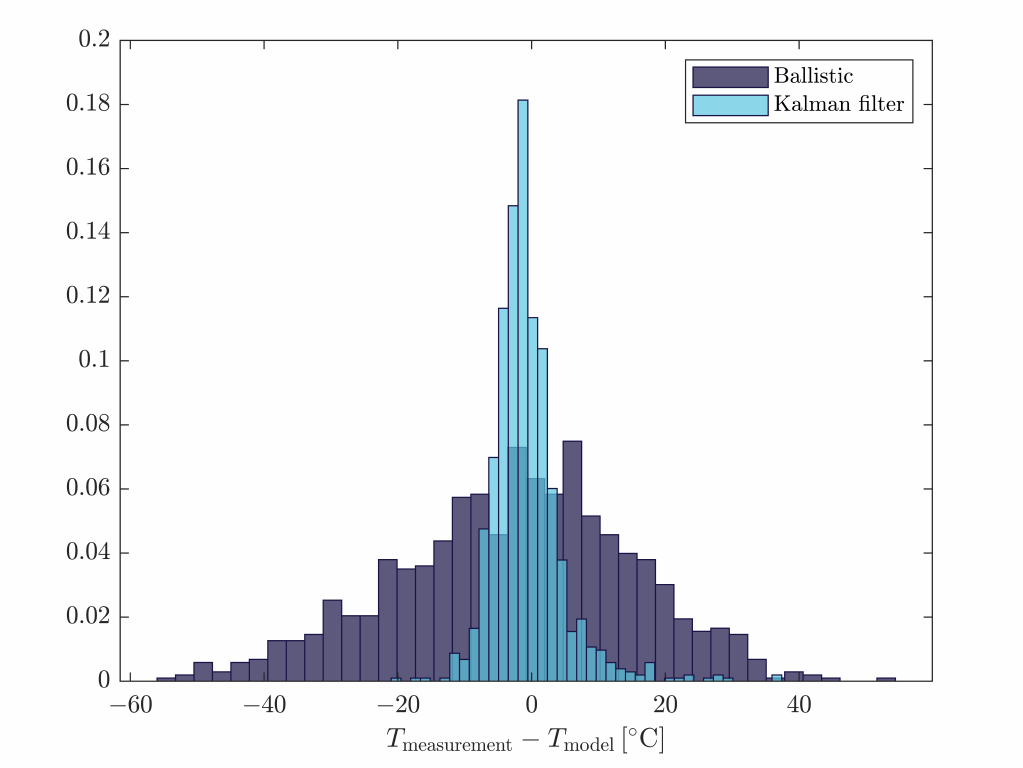
Figure 3. Histogram showing improvement of prediction errors by estimation on the final tempera- ture estimates in the